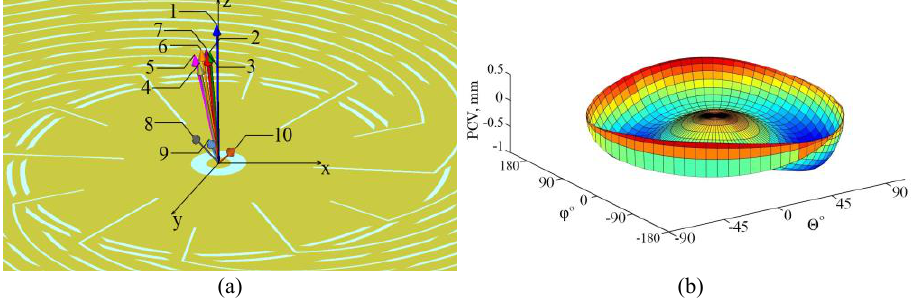
Fig. 6. (a) Graphic representation of the offsets of the antenna phase centers relative to its geometrical center, (b) graphic representation of the simulated PCV.